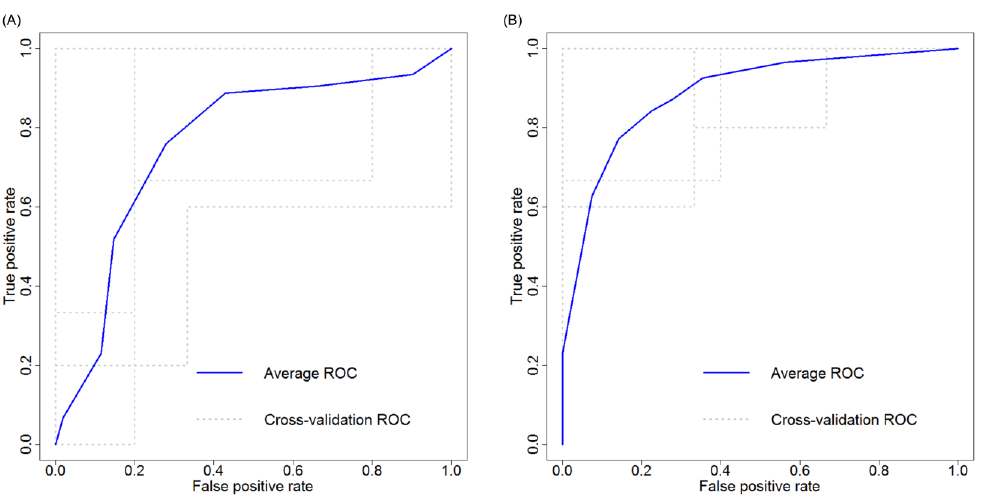
Figure 4. K-fold (5-fold) cross validation ROC curve of serum miRNA panels to identify cirrhosis or HCC in chronic Hepatitis C ( A ) miRNA panel (miRNA-122-5p and miRNA-409-3p) 5-fold cross validation performance to identify cirrhosis, compared to mild disease, demonstrates an AUC of 0.79 (95% CI 0.65–0.93). ( B ) miRNA panel to identify HCC, compared to cirrhosis, using miRNA-122-5p, miRNA-486-5p, and miRNA-142-3p, demonstrates an AUC of 0.91 (95% CI 0.81–1.0). (Abbreviations: AUC = area under the curve; F0-2 = mild disease; F4 = cirrhosis; HCC = hepatocellular carcinoma; miRNA = microRNA; ROC = receiver operating characteristic; 95% CI = 95% confidence